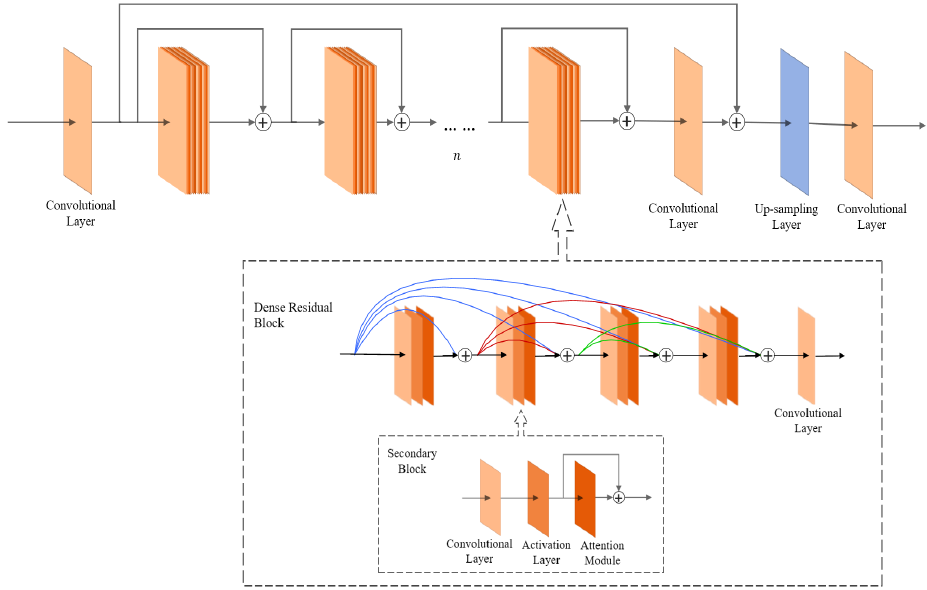
Figure 9. Multilayer attention-dense